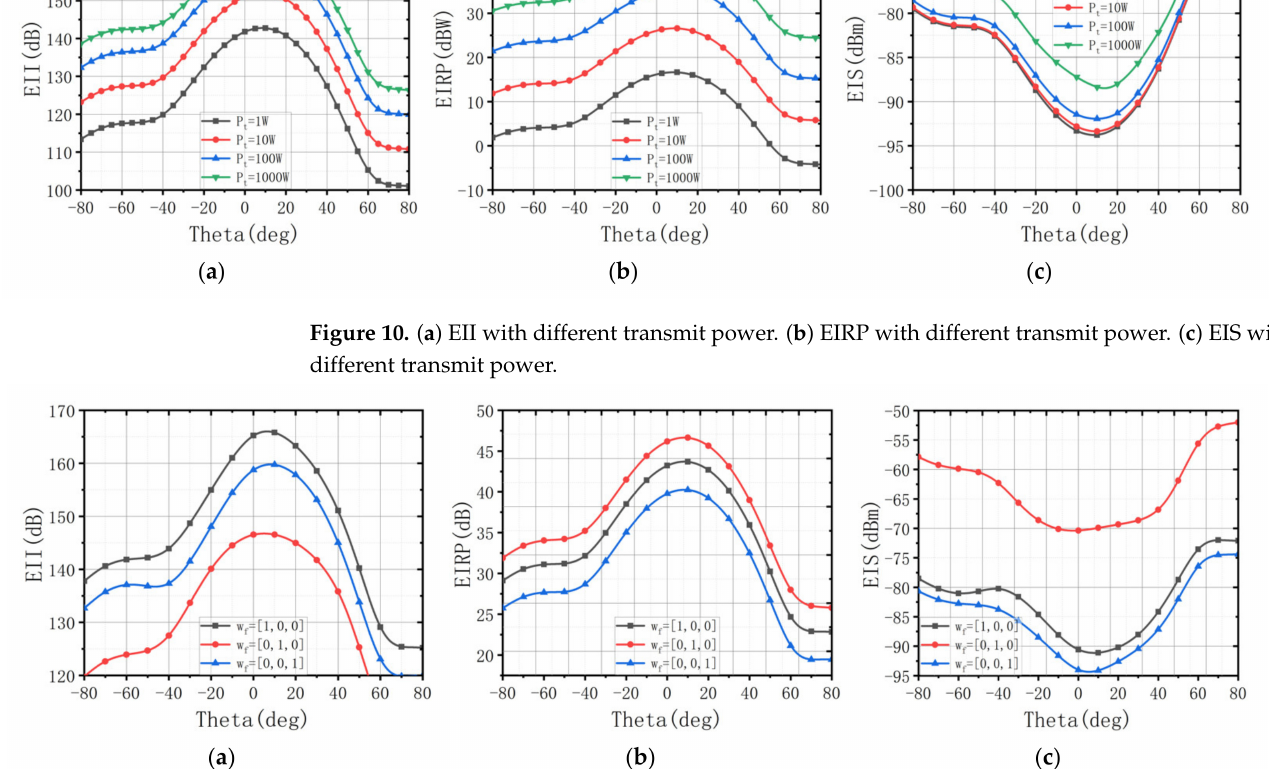
Figure 11. ( a ) EII with different w f . ( b ) EIRP with different w f . ( c ) EIS with different w f